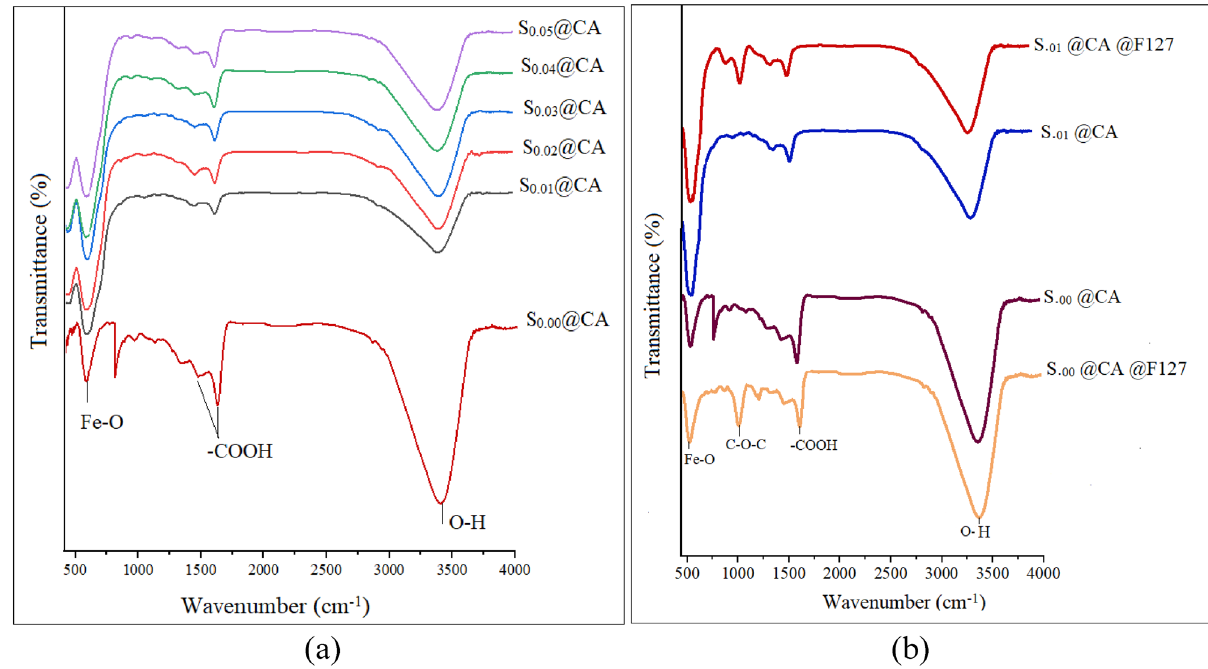
Figure 6. ( a ) FTIR spectra of Sm 3+ and Zn 2+ co- substituted magnetite nanoparticles coated with CA and ( b ) FTIR spectra of S .00 and S .10 samples coated with CA and CA@F127, i.e., FS .00 and FS 0.01 , respectively.